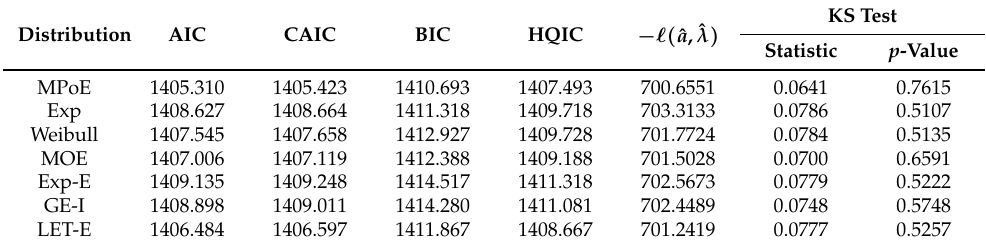
Table 10. Adequacy measures for coal mining data set.